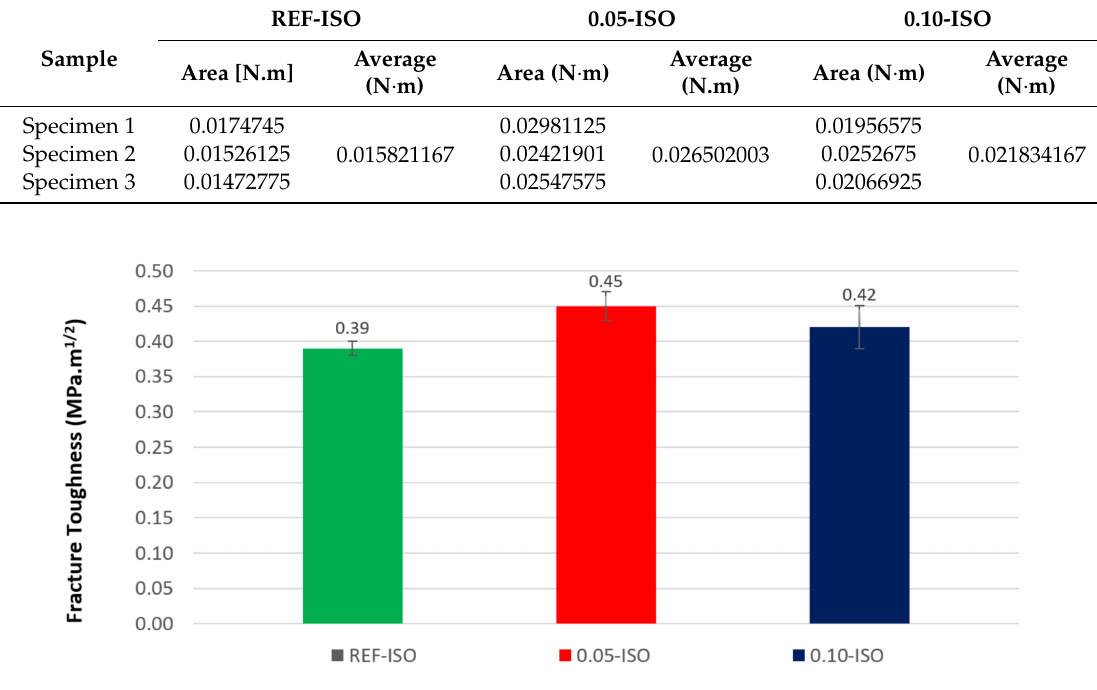
Figure 8. Fracture toughness